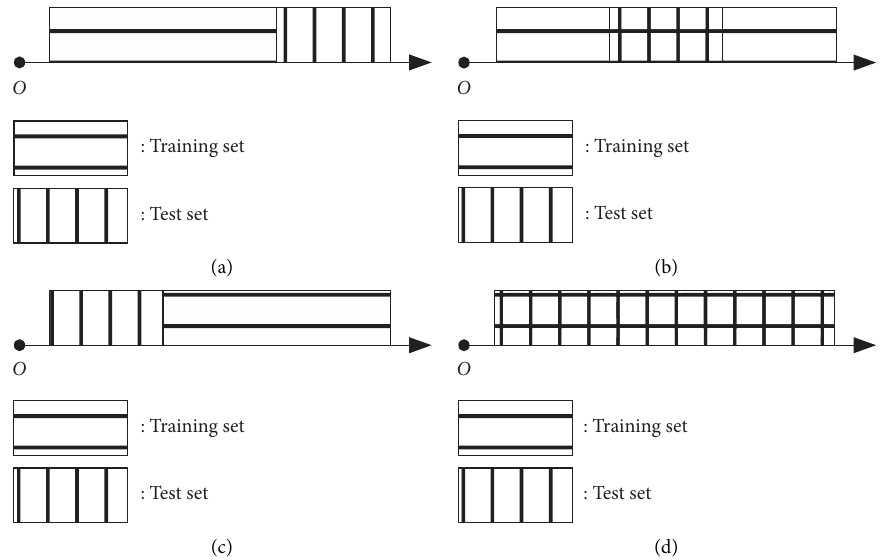
Figure 12: Four models of derivation. (a) The test set sample is larger than the upper limit of the training set sample interval. (b) The test set samples are in the training set sample interval. (c) The test set sample is smaller than the training set sample interval lower limit. (d) The sample interval of the test set is equal to that of the training set.